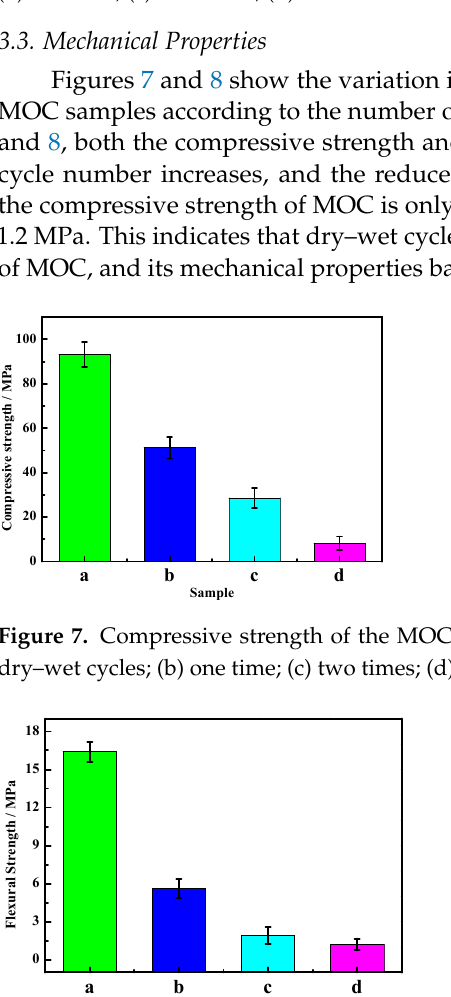
Figure 6. Bulk density of the MOC samples after different dry–wet cycles: (a) without dry–wet cycles; (b) one time; (c) two times; (d) three times.